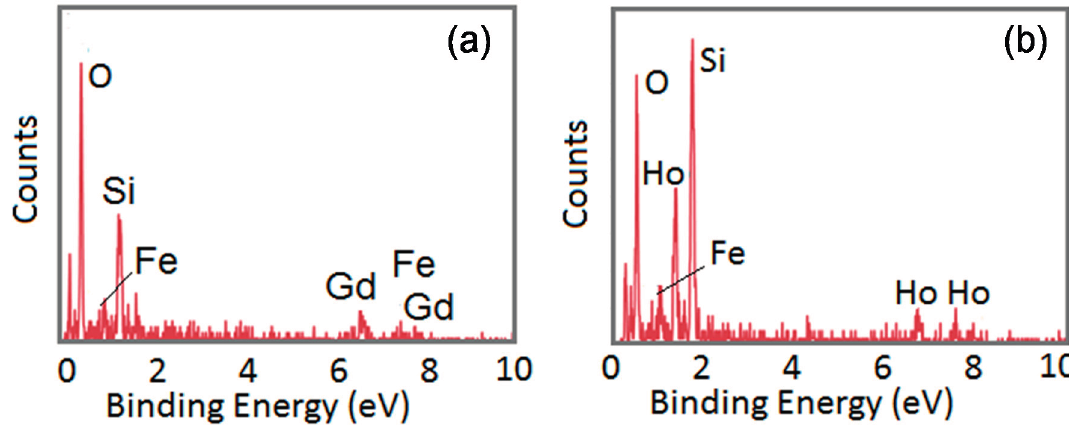
Figure 4. SEM/EDX analysis of the chemically-synthesized ( a ) Fe 43±18 Gd 2±0 O 55±18 and ( b ) Fe 3±1 Ho 11±2 O 85±3 magnetic